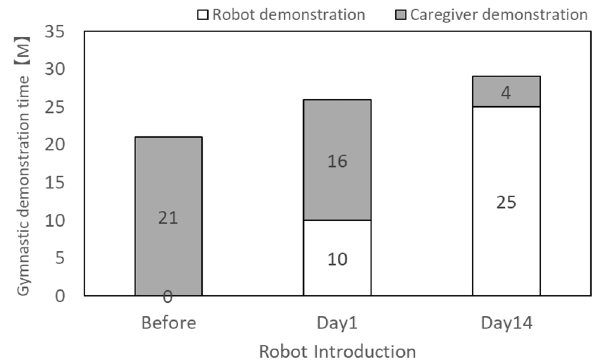
Fig. 4 Ratio of gymnastics demonstration time between the robot and the caregiver